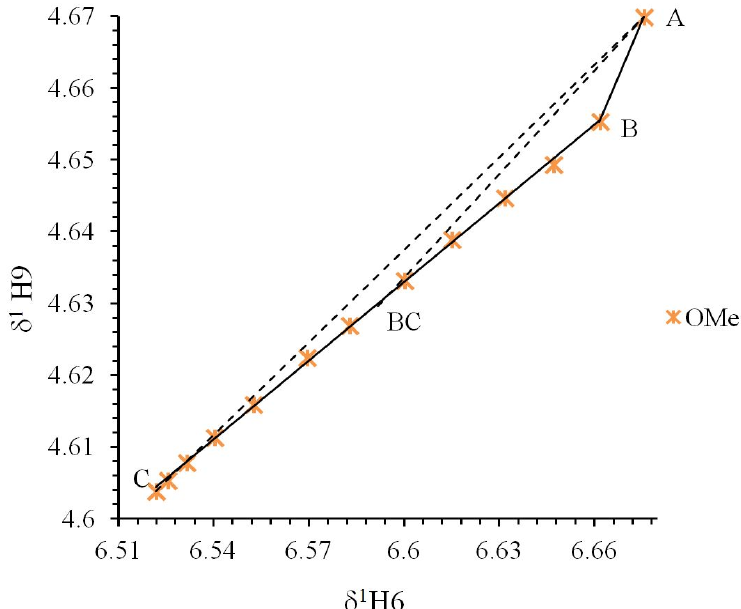
Figure 5. Polster-Lachmann analysis of the δ -diagram from compound 5 . Point “A” shows the initial state, point “B” indicates a change on the compound (neutralization point), point “C” the final state and point “BC” is the experimental Δ K of the system. The dotted line NHO A to C shows the shape of a triangle; the dotted line from vertex A to point BC shows the equilibrium intercept in an Δ K NHO